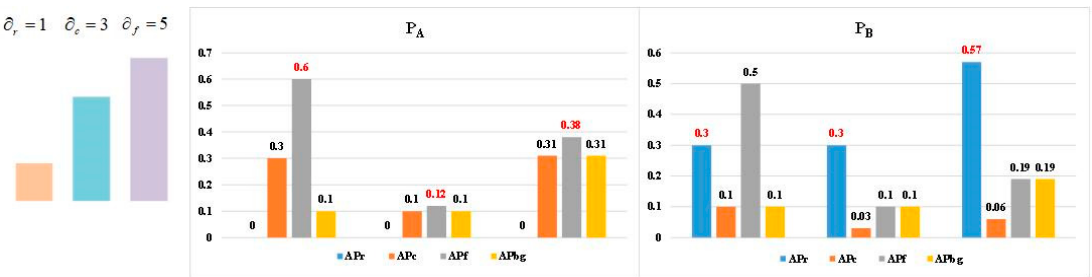
Figure 4. Post-processing calibration application.